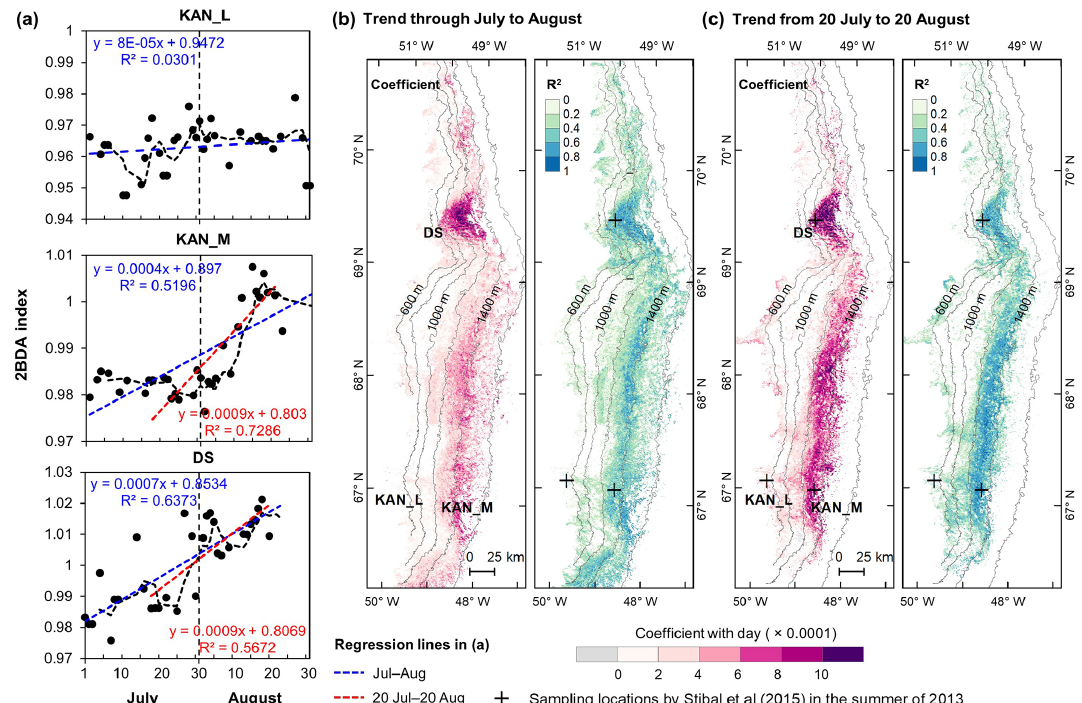
Figure 8. Temporal trends of the 2BDA index over July and August. (a) The 2BDA time series and temporal trend analysis over the KAN_L, KAN_M, and DS sites. (b) Regression slope and R 2 estimates of the temporal trend analysis for the period of July–August (for areas where the p value < = 0.05). (c) Regression slope and R 2 estimates of the temporal trend analysis for the period of 20 July–20 August (for areas where the p value < = 0.05).